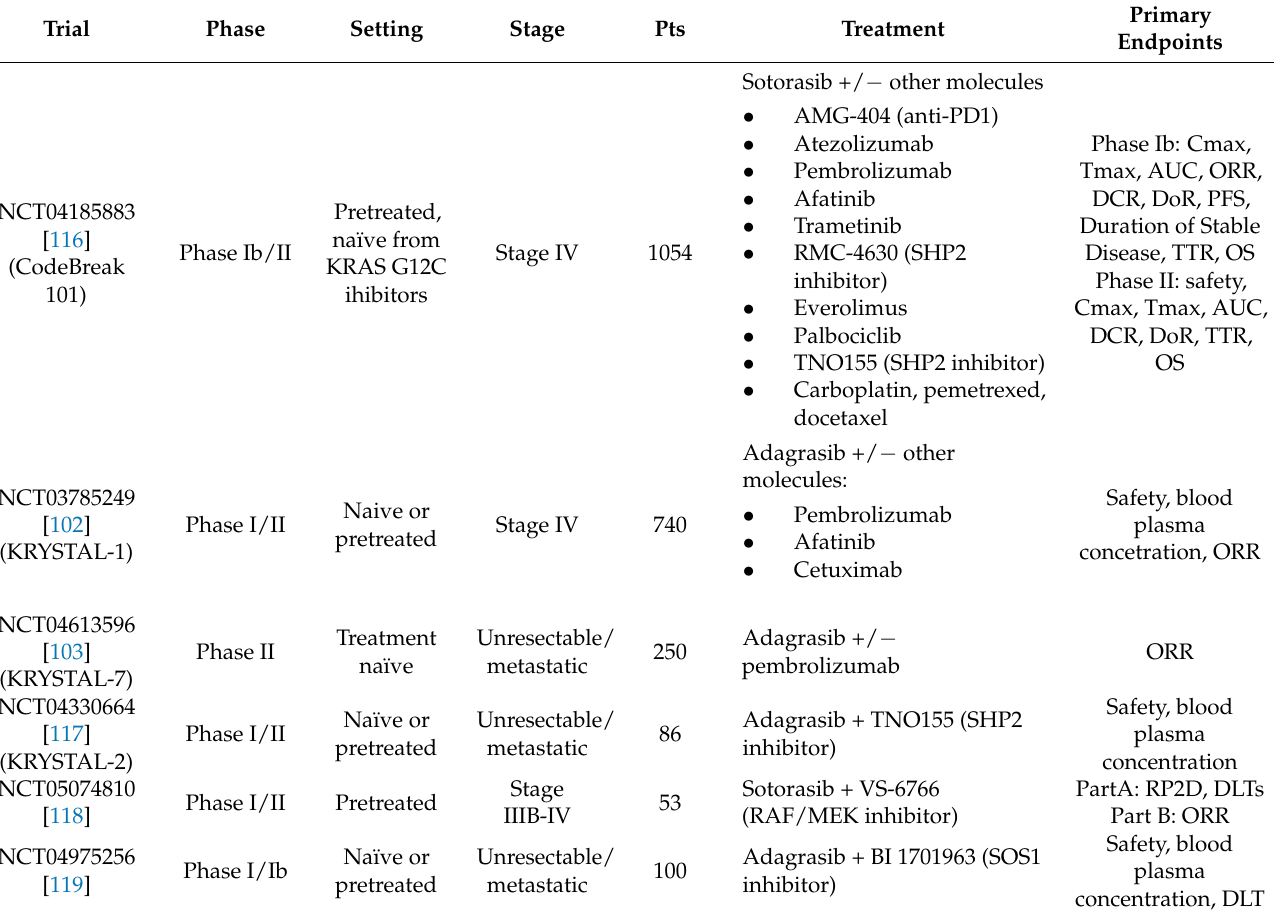
Table 3. Ongoing trials evaluating sotorasib/adagrasib combined with other agents in KRAS-G12 mutant advanced